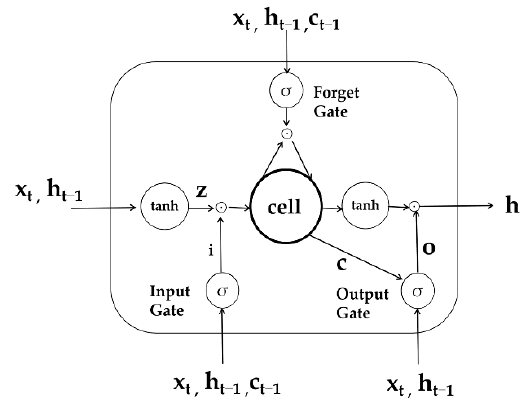
Figure 5. Structure of LSTM unit.